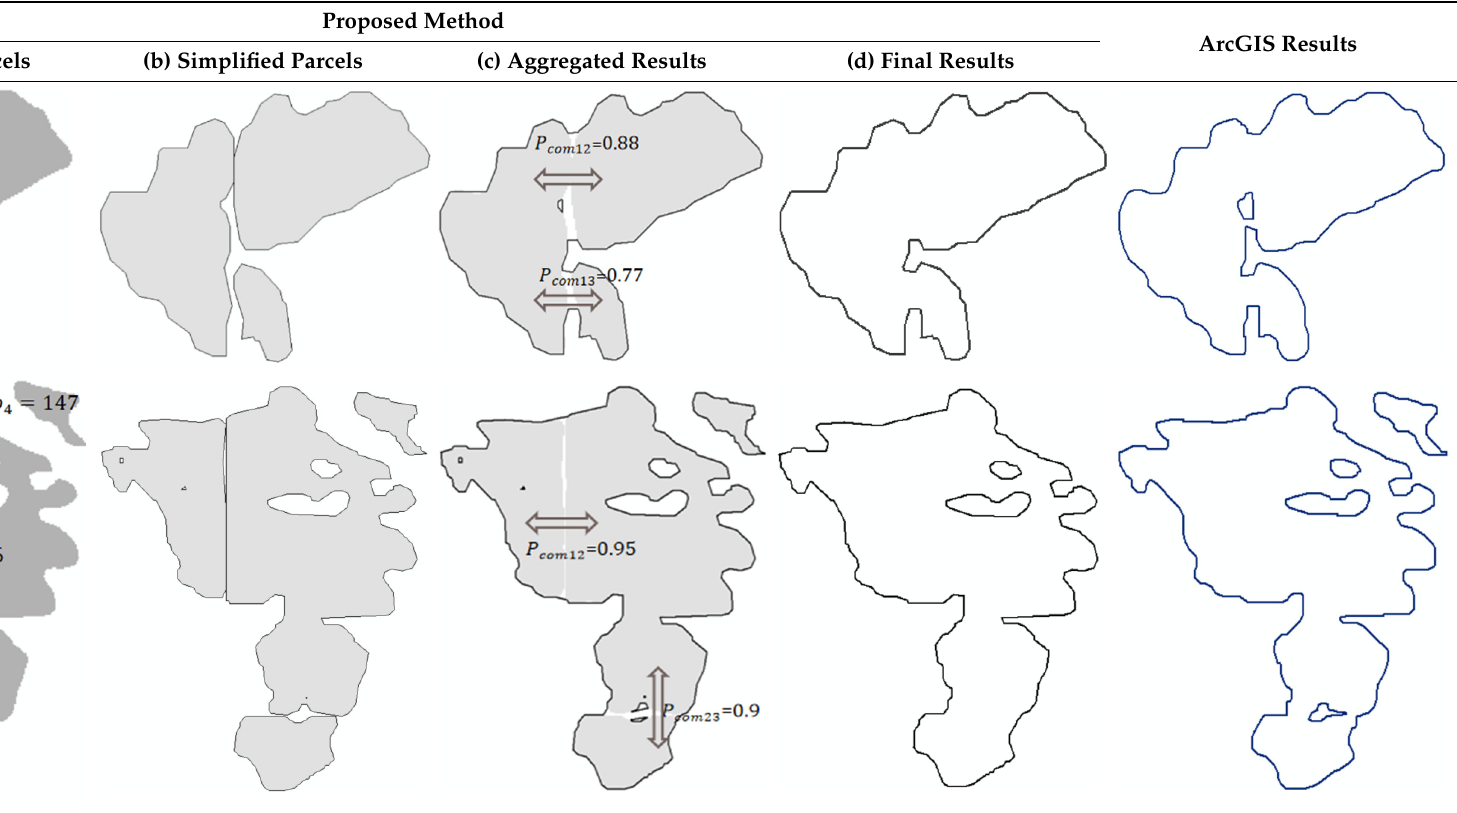
Table 2. Results of the parcel optimization process.